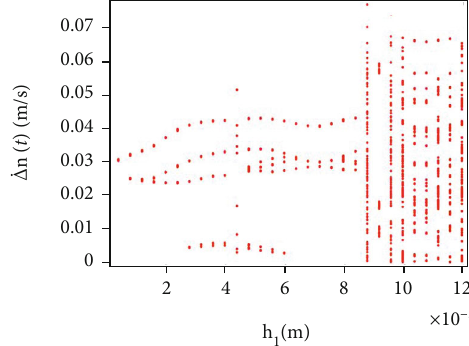
Figure 21: Bifurcation diagrams with changes in the wear when the misalignment in the x direction is 3 : 4 × 10 − 4